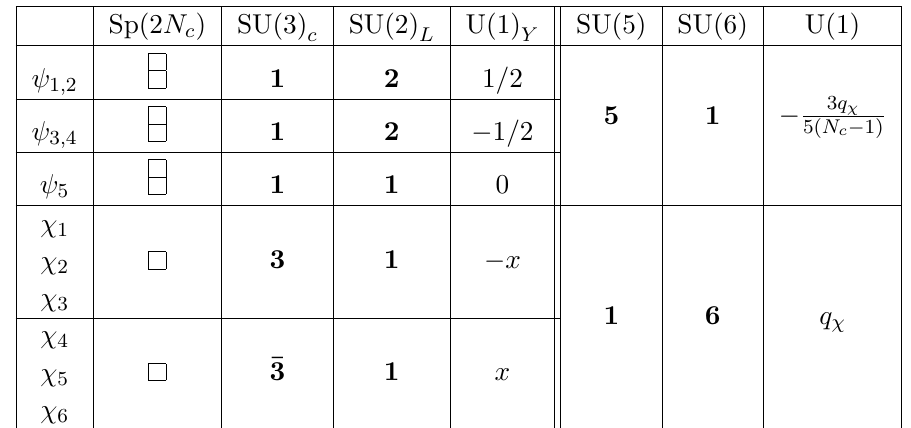
Table 1. Field content of the microscopic fundamental theory and transformation properties under the gauged symmetry group Sp(2 N SU(5) × SU(6) × U(1)